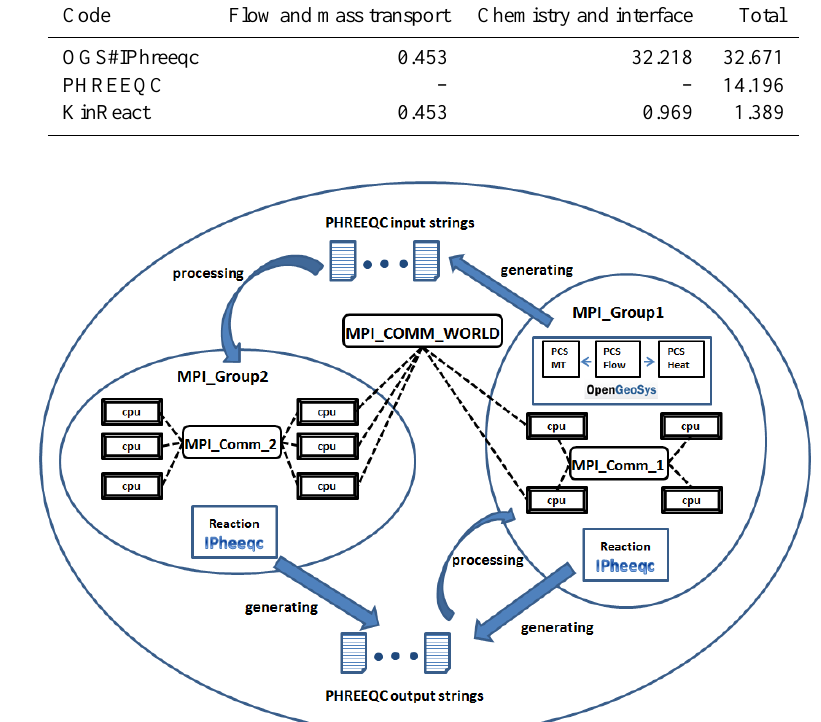
Table 5. An overview of different portions of the simulation time for the van Breukelen benchmark by using different codes (in seconds).